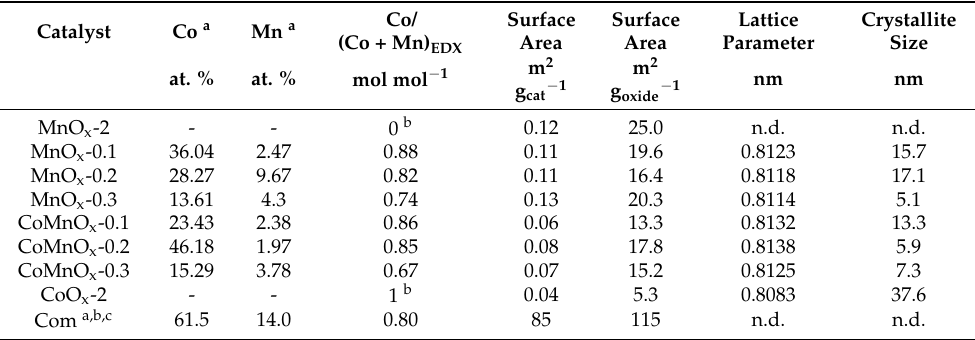
Table 2. Composition, surface area of the prepared catalysts, lattice parameters, and crystallite sizes of spinel-type